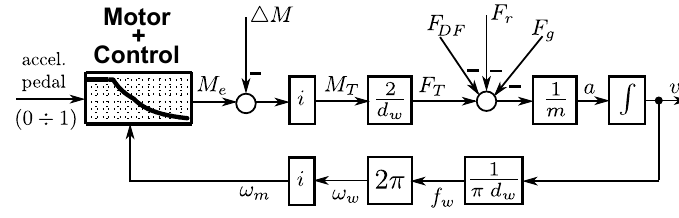
Figure 5. Powertrain model ver. 1.